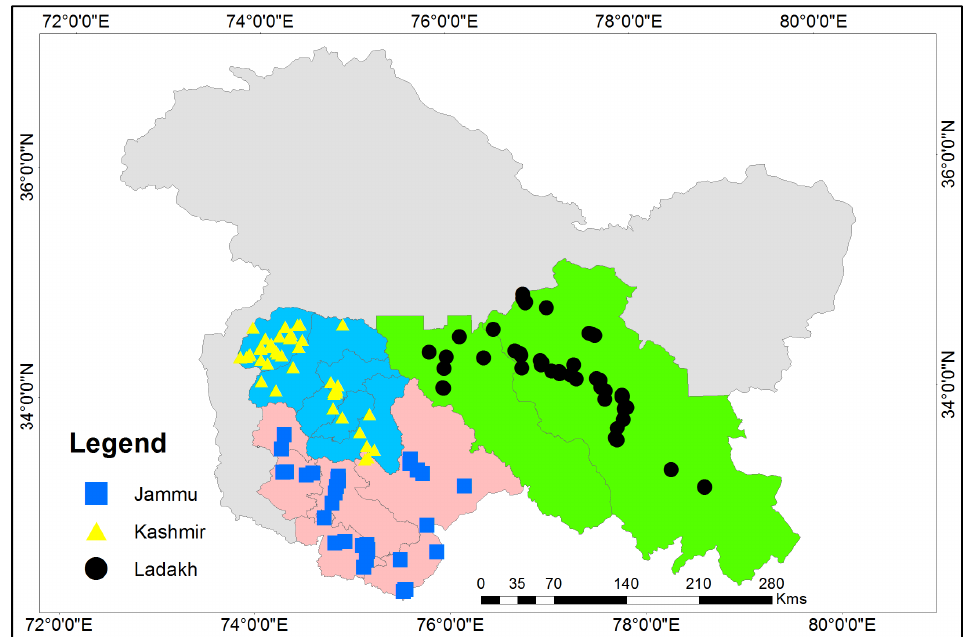
Figure 1. Map of the Jammu and Kashmir (J and K) and point showing the sampling sites in erstwhile states of Jammu and Kashmir.